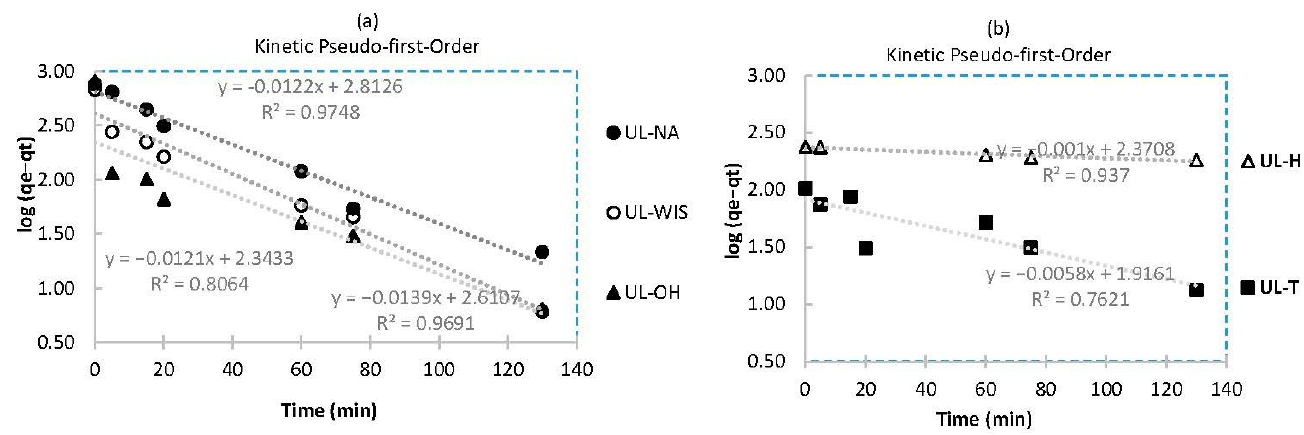
Figure 10. Kinetic pseudo-first-order of MB adsorbed by dry U. lactuca biomass: UL-NA, UL-WIS, and UL-OH ( a ), UL-H and UL-T ( b ). Experimental conditions: 5 g L −1 of adsorbent concentration, pH = 8, T = 25 °C, C 0 (MB) = 5 × 10 −5 mol/L. Table 5. Kinetic parameters of biosorption of MB on dry U. lactuca biomass.